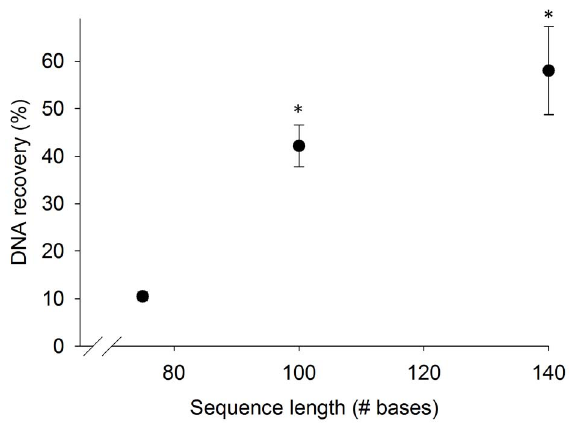
Figure 6. The LOD of the PCR reaction is shown at 8800 copies (dotted line). The lowest initial concentration of IS6110 DNA detectable at the LOD was determined to be 77 copies/ m L at the point at which this intersects the PCR-concentration curve (red circle) (mean 6 s.d., n=3).